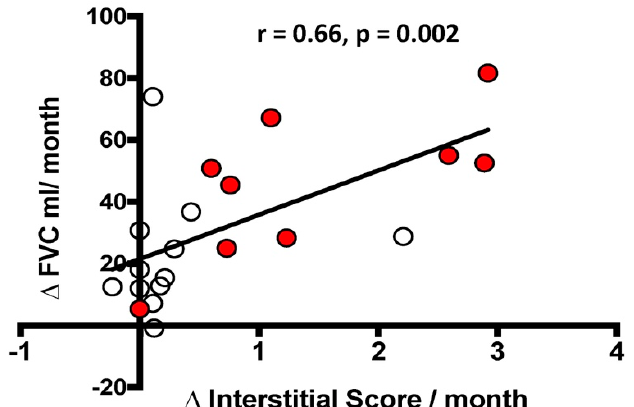
Figure 5. Relationship between the change over time in FVC mL ( Δ FVC mL/month) and the change over time in Interstitial Score ( Δ Interstitial Score/month). The black line represents the correlation in the entire population. White circles indicate slow progressors and red circles represent rapid progressors. Spearman’s rank correlation: r = 0.66, p = 0.002 in the entire population; r = 0.31, p = 0.6 in slow progressors alone; r = 0.73, p = 0.06 in rapid progressors alone.